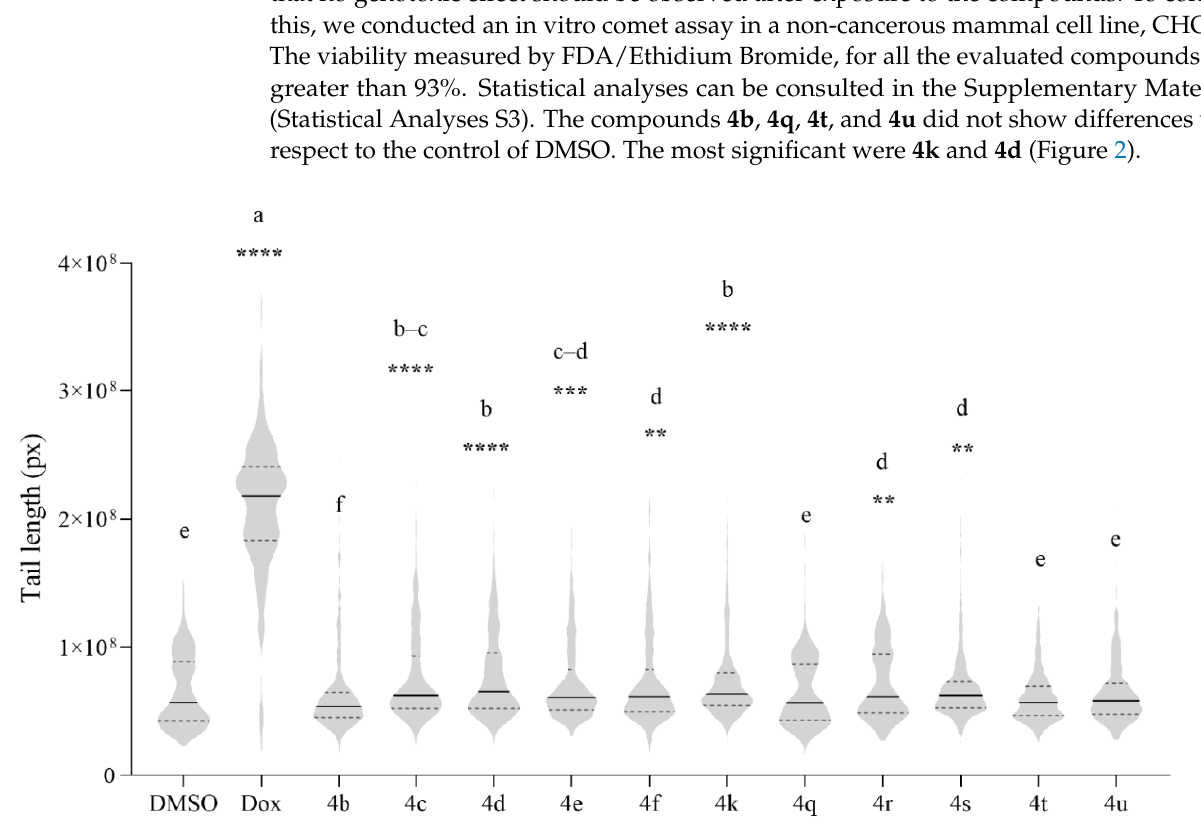
Figure 2. Comet assay of de CHO-K1 cells exposed to bis(spiropyrazolone)cyclopropanes 4. Violin plots of tail length measurements from a comet population, are represented. Black traits indicate the median and dashed traits the highest and lowest quartiles of each population. DMSO: dimethyl sulfoxide; Dox: doxorubicin. The tests for significance were limited to the Kruskal–Wallis one-way ANOVA. Post hoc tests were done by using the criterium Fisher’s least significant difference. Treatments with the same letter are not significantly different. Significance codes: **** p < 0.0001; *** p < 0.001; ** p < 0.01.